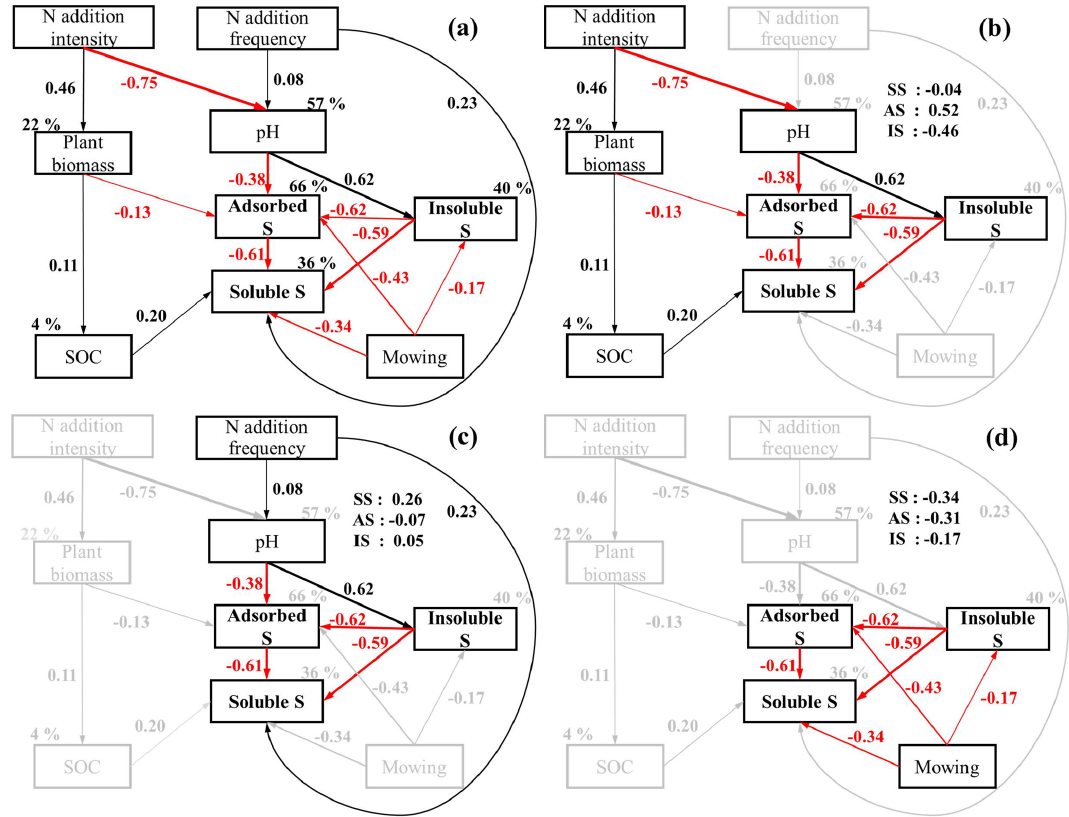
Figure 7. Structural equation modeling (SEM) illustrating the pathways of effects of N addition intensity, frequency, and mowing on soil parameters and inorganic S fractions. Panel (a) shows the original model, panel (b) depicts the pathways related to effects of N intensity, panel (c) depicts the pathways related to effects of N frequency, and panel (d) depicts the depicts the pathways related to effects of mowing. Arrows indicate significantly positive (black) and negative (red) effects with the effect size proportional to arrow width. Numbers adjacent to arrows are standardized path coefficients, and percentages next to the endogenous variables indicate the variance explained by the model ( R 2 ). The numbers in the top-right corner denote the standardized total effects of N intensity, frequency, and mowing on soluble S (SS), adsorbed S (AS), and insoluble S (IS), respectively. The final SEM fitted the data well as suggested by the fitting parameters ( χ 2 = 21 . 06, d f = 23, P = 0 . 58, RMSEA = 0.000, and AIC =